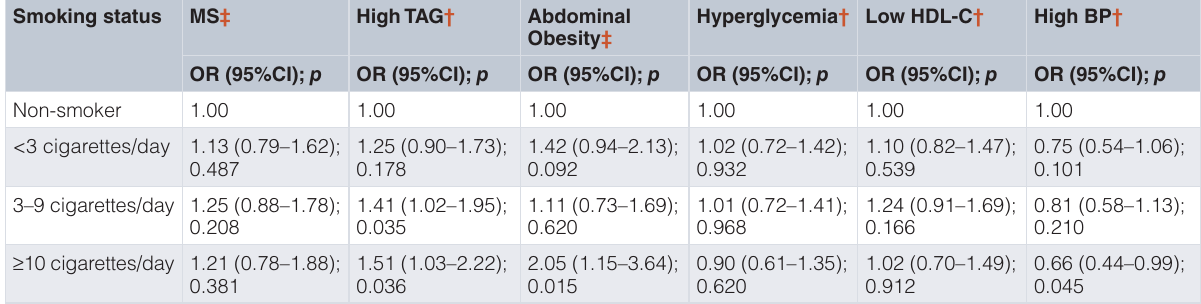
Table 4. Adjusted odds ratios for MS and its components according to smoking habit intensity in Maracaibo,